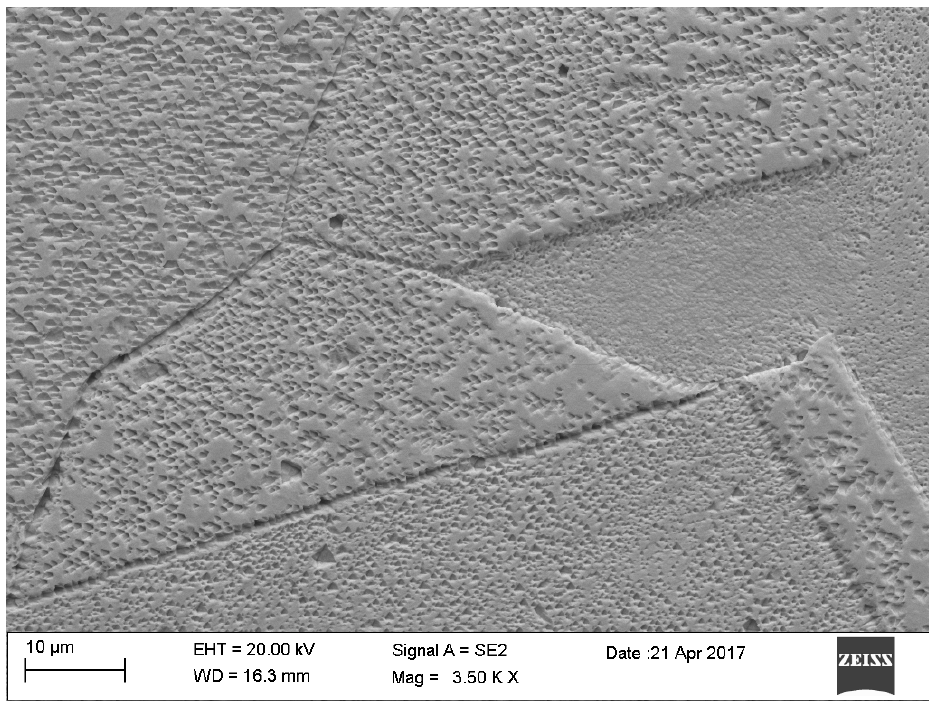
Figure 9. Large Au grains with twins in the structure.